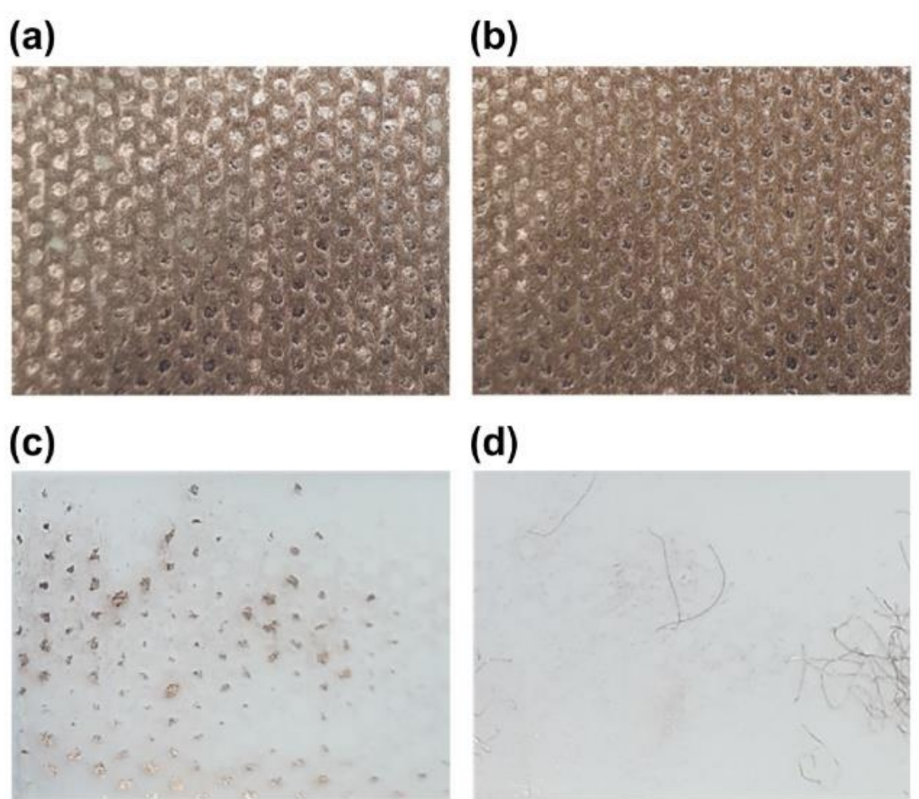
Figure 3. Tape adhesion testing of KF94 masks. Digital photographs of the copper-coated mask surfaces ( a ) without and ( b ) with oxygen ion beam pretreatment and of the surface of the removed tape ( c ) without and ( d ) with oxygen ion beam